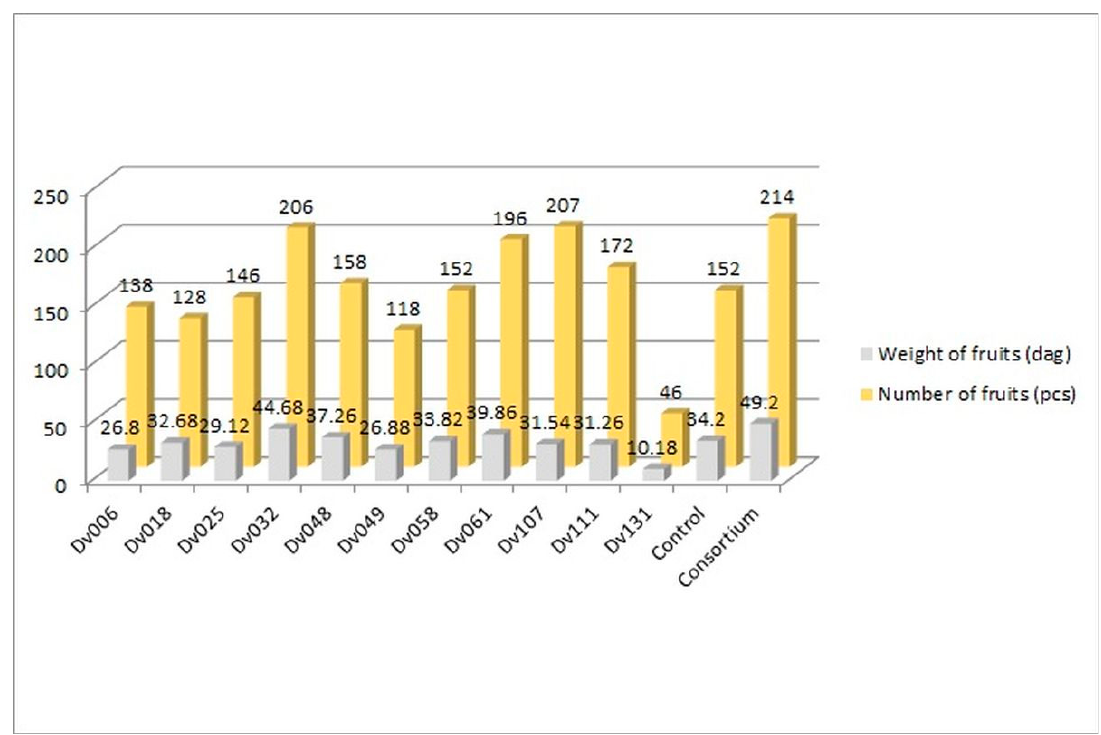
Int. J. Mol. Sci. 2022 , 23 , x FOR PEER REVIEW Figure 1. Comparison of the amount and weight of tomatoes from all 13 treatments.